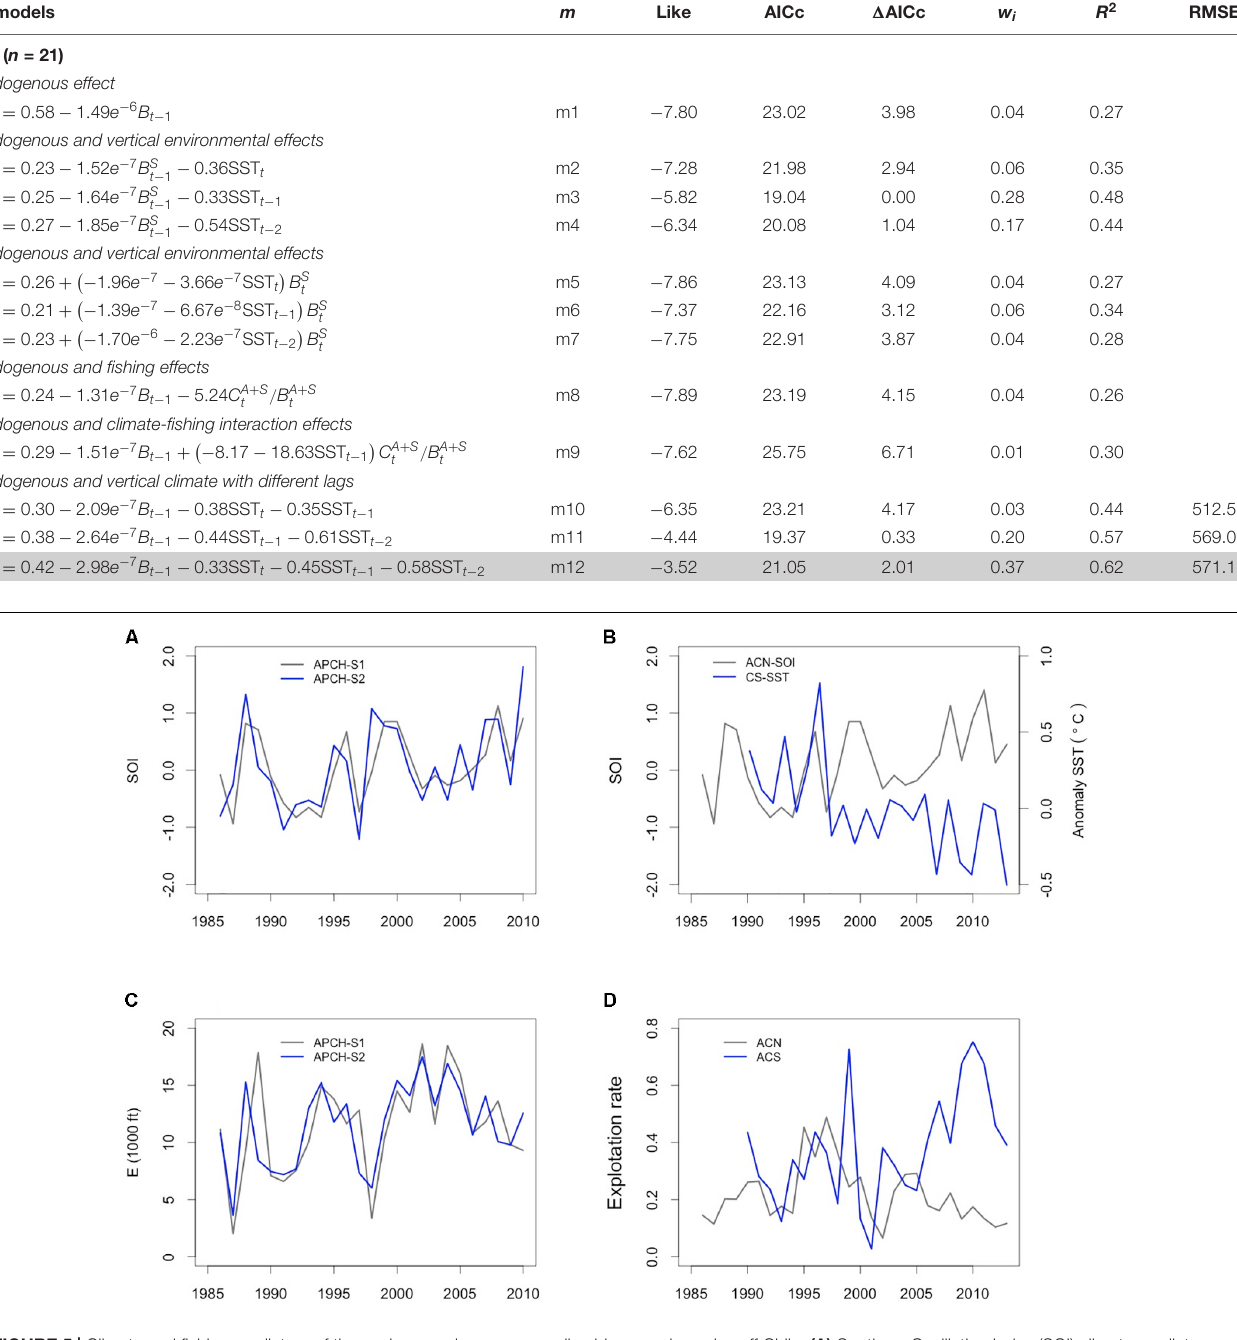
( Supplementary Table S1 ). Therefore, these features preclude their incorporation into the population models proposed in this study for these